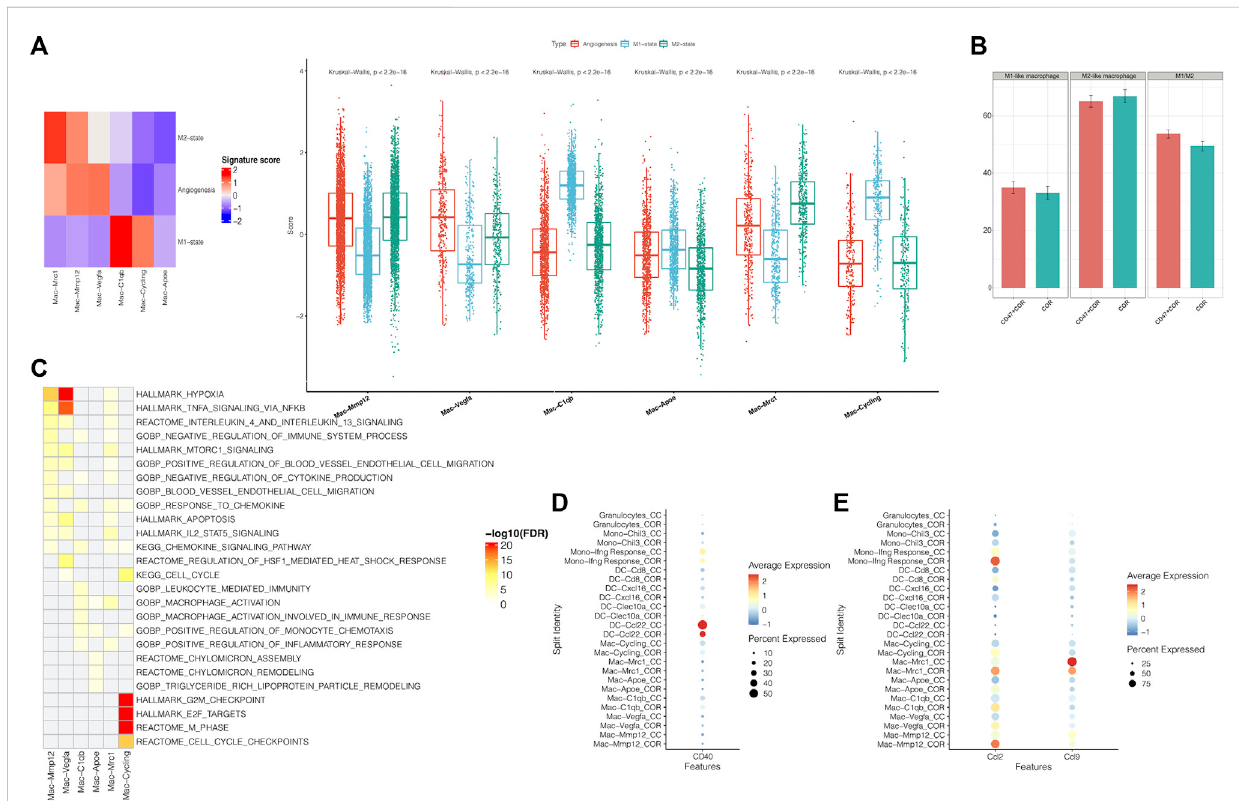
FIGURE 4 Function of sub-clustering in myeloid cells is con fi rmed by scRNA-seq (A) . Using the scRNA-seq data, M1-state, M2-state, and angiogenesis signature scores for each myeloid cell cluster are shown by a heatmap and boxplot (B) . This bar graph shows the changes of M1-like macrophages and M2-like macrophages (C) . Using theKEGG database , pathwayswere signi fi cantly enriched inthe scRNA-seq data for each macrophagecluster (D) . A dot plot showed the expression of CD40 on myeloid cells in MC38 tumors from the combination treatment group or cordycepin group (E) . Different expressionsofchemokinesindifferentsubpopulationsofmyeloidcellsareshownbyadotplotinMC38tumorsfromthecombinationtreatmentgroupor cordycepin group. “ COR + CD47 ” represents the combined treatment group; “ COR ” represents the cordycepin treatment